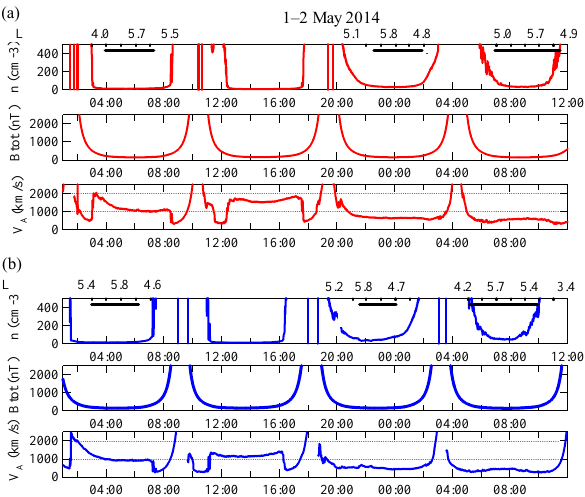
Figure 13. From top to bottom densities, total magnetic field strengths and Alfvén velocities vs. universal time for Van Allen Probes A (plotted in red) and B (plotted in blue) from 01:00UT on 1 May 2014 to 12:00UT on 2 May 2014. Solid black bars show inter- vals when Pc4 pulsations were observed on orbits 1, 3 and 4. Ticks above the panels show spacecraft L values for the corresponding